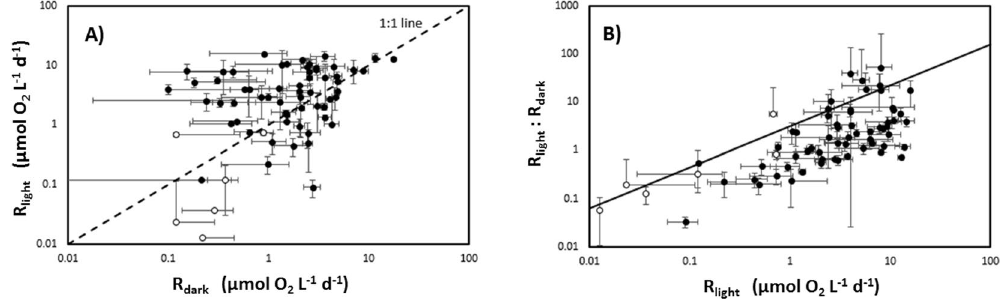
Figure 3. The relationship between ( A ) respiration in the dark (R dark ) and that in the light (R light ), and ( B ) respiration in the light (R light ) and the ratio between respiration in the light and that in the dark (R light :R dark ) in the Svalbard region (black symbols) and in Young Sound (white symbols). The solid line in ( B ) shows the fitted regression line Ln (R light :R dark ) = − 0.02 + 0.68 * Ln (R light ) ( µ mol O 2 L − 1 d − 1 ), R 2 = 0.50, P < 0.001. Error bars are the